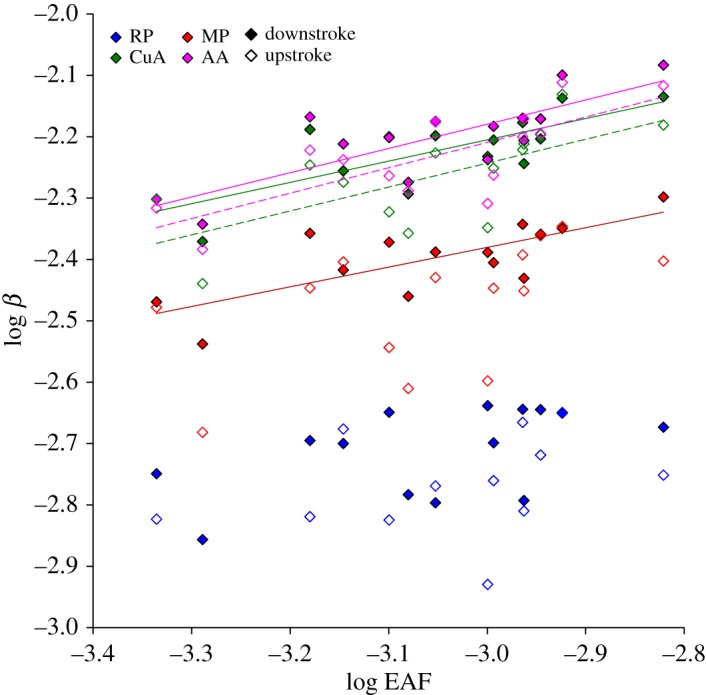
Logarithmic relationship between wing deflection (β) and the estimation of aerodynamic force (EAF). Filled and open symbols denote deflections during mid-downstroke and mid-upstroke, respectively. Colours and landmark names are as in figure 1a. Statistically significant linear regressions (on log-transformed data) are denoted by a trend line; see table 2 for elaborated statistics.